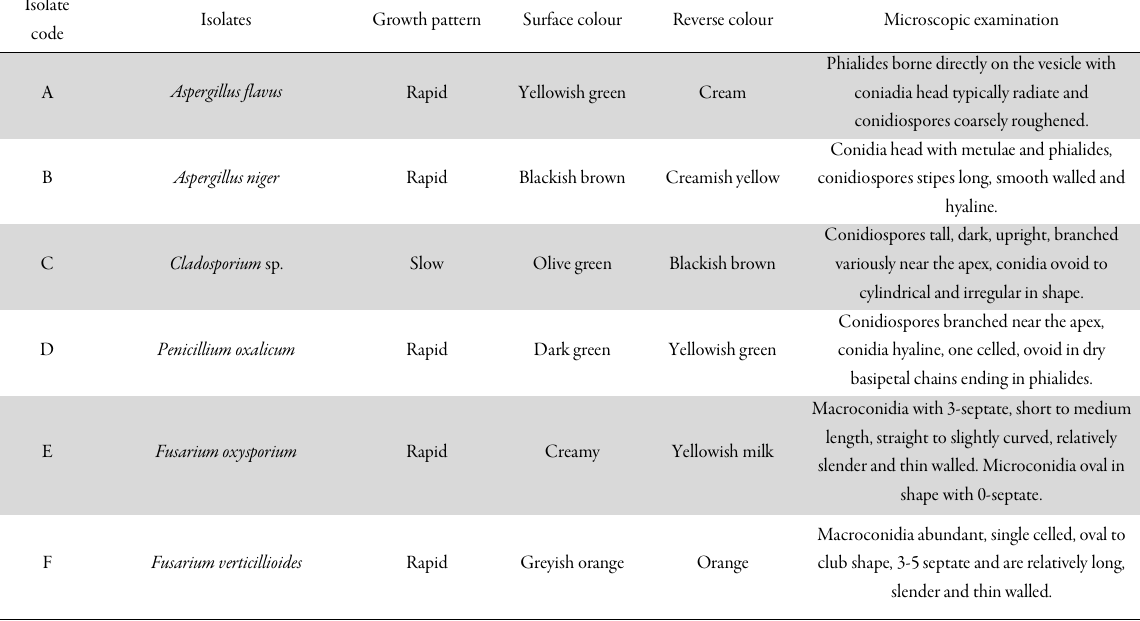
Table 1. Morphology, cultural characteristics and microscopic examination of fungal isolates from infected Pleurotus ostreatus